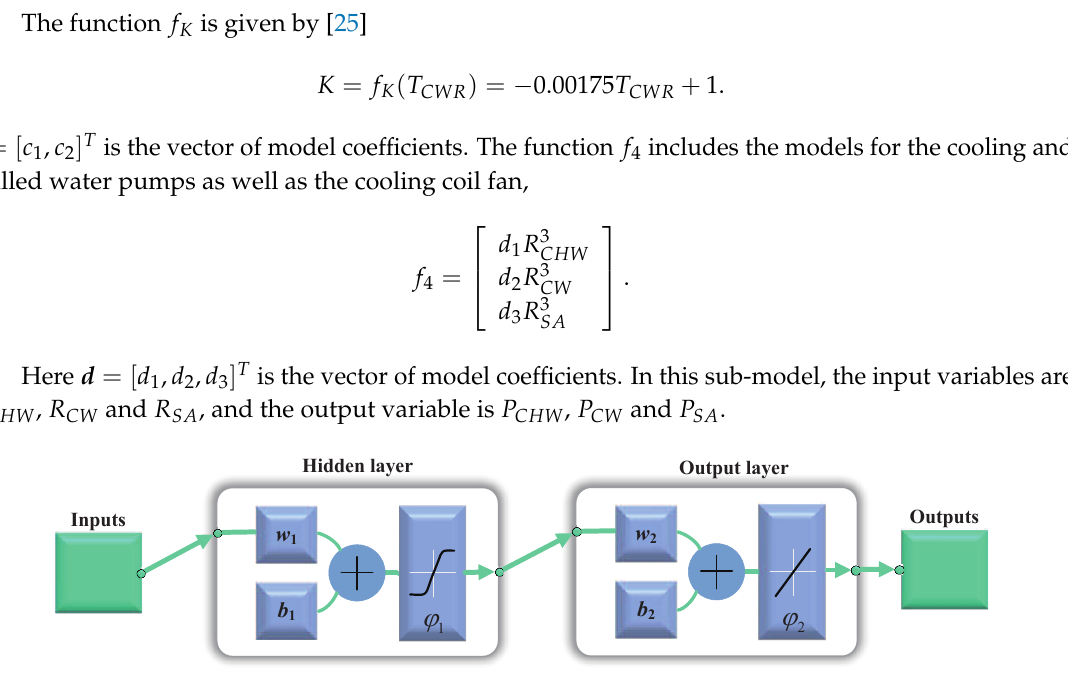
Figure 3. A two-layer feed-forward network as the chiller